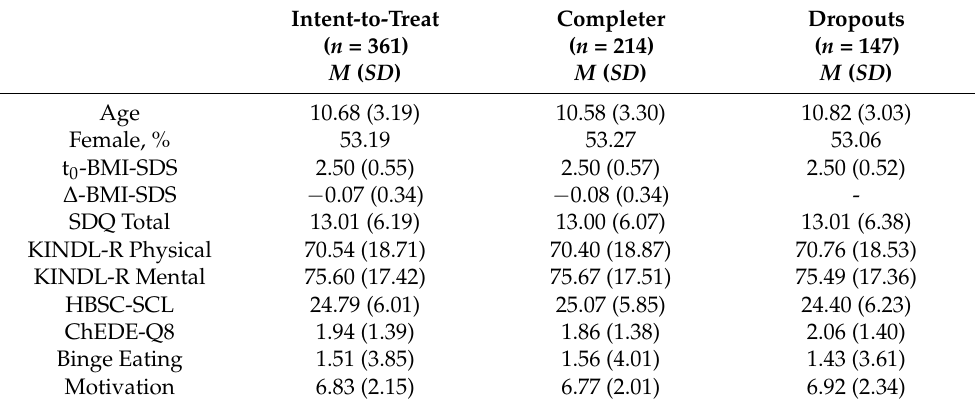
Table 1. Descriptive statistics for the intent-to-treat sample and the completer/dropout